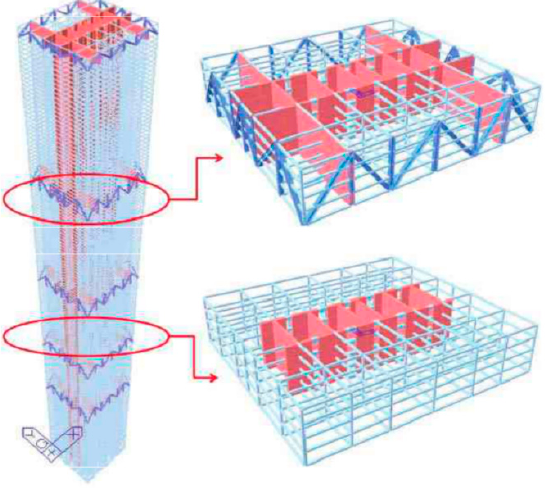
Figure 11. The high-rise building deformation monitoring model analysis